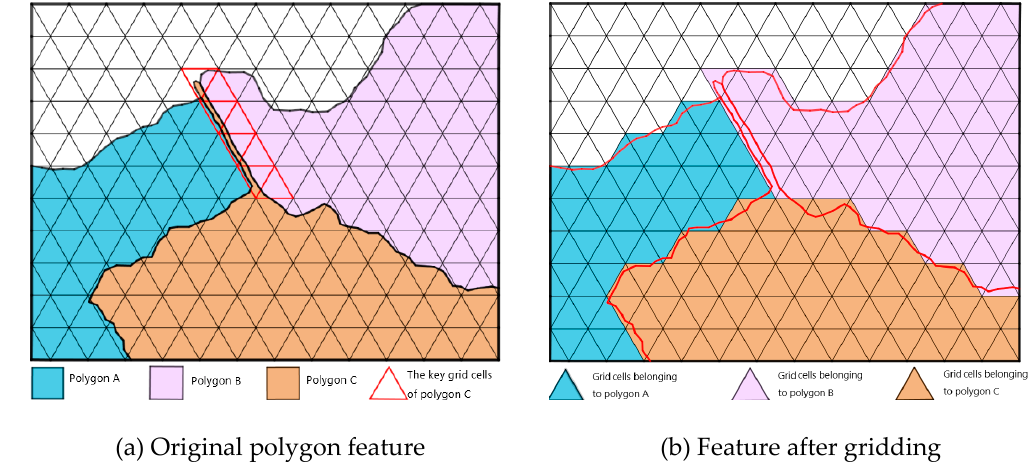
Figure 6. Change from disjoint to meet after the gridding of polygon features.